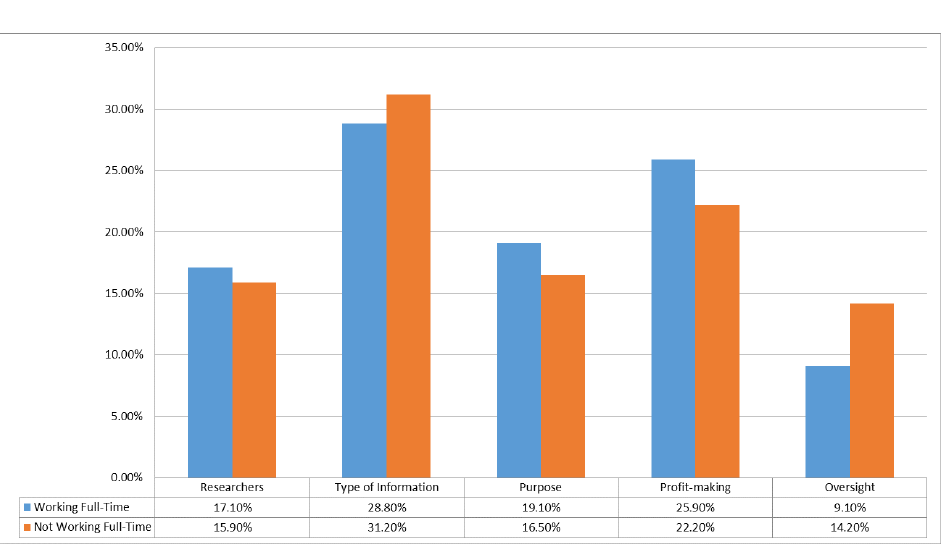
Figure 4: Relative Importance of Attributes for Participants according to Working Status